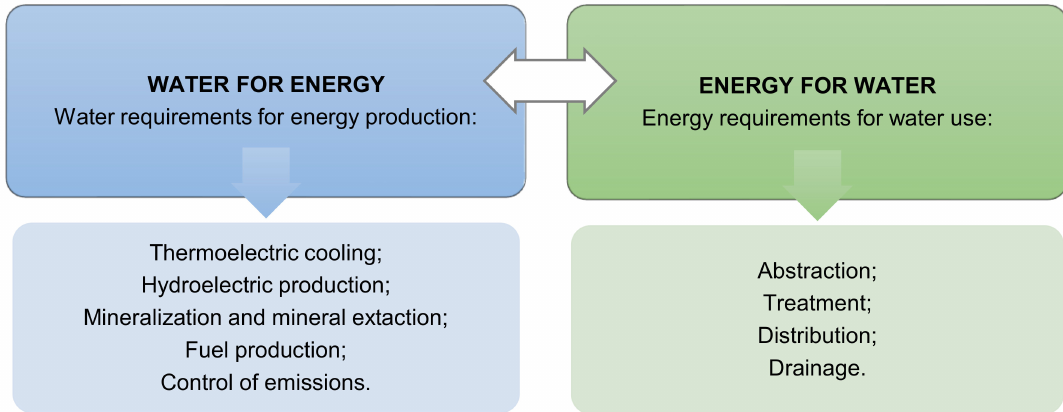
Figure 1. Water–energy nexus (adapted from APA